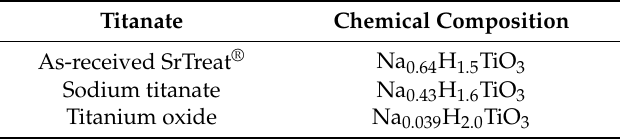
Table 2. Chemical compositions of the titanates in the present study estimated from the EDX results. Titanate Chemical